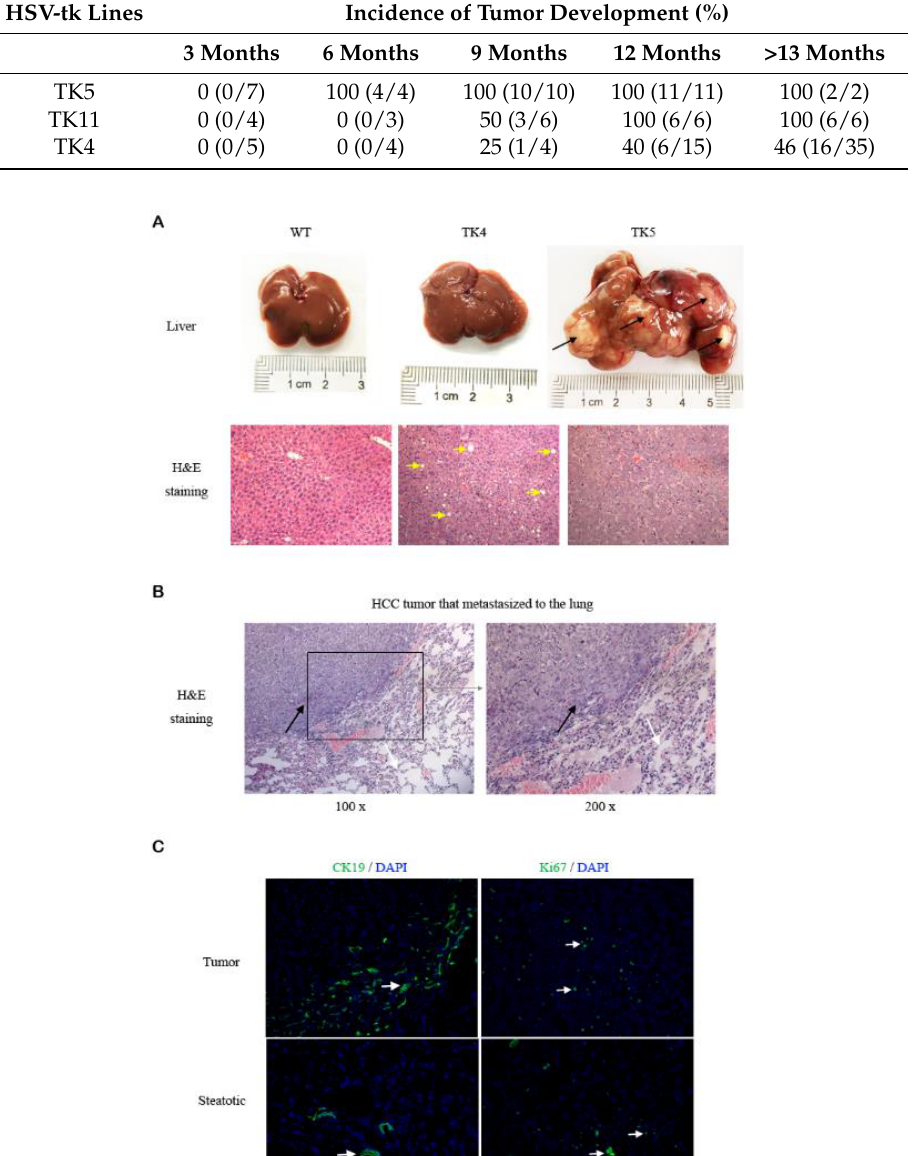
Table 3. The incidence of Hepatocellular Carcinoma (HCC) in three lines HSV-tk mice. HSV-tk Lines